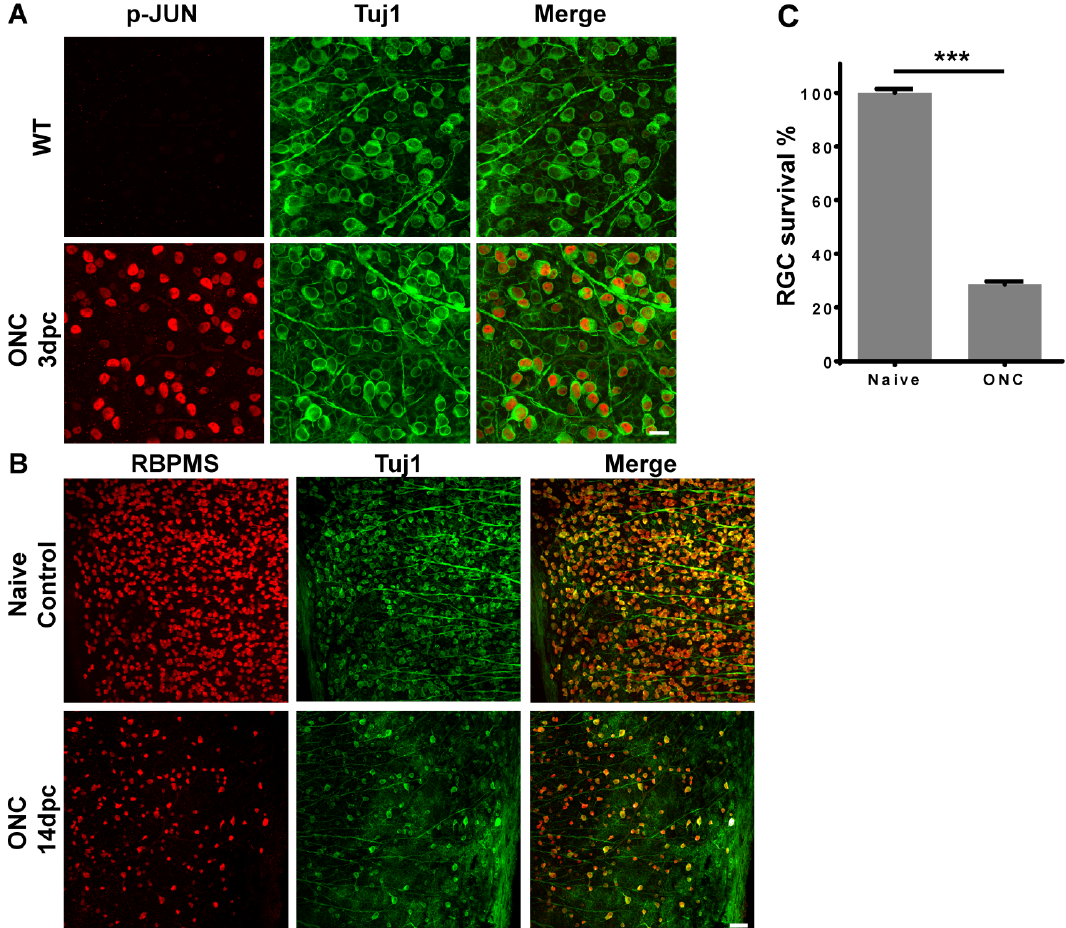
Figure 1. ONC injury increases JUN phosphorylation and results in RGC death. ( A ) Representative images of whole retina co-immunostained with antibodies against phospho-JUN and β III tubulin (Tuj1), scale bar: 20 μ m; ( B ) Representative images of whole retina co-immunostained with antibodies against RBPMS (RGC marker) and β III tubulin (Tuj1), scale bar: 50 μ m; ( C ) Statistical analysis of RGC survival 14 days after ONC injury. Data are represented as mean ± SEM, n = 9; *** p < 0.001; 3 dpc: 3 days post-crush; 14 dpc: 14 days post-crush; ONC, optic nerve crush; RGCs, retinal ganglion cells.